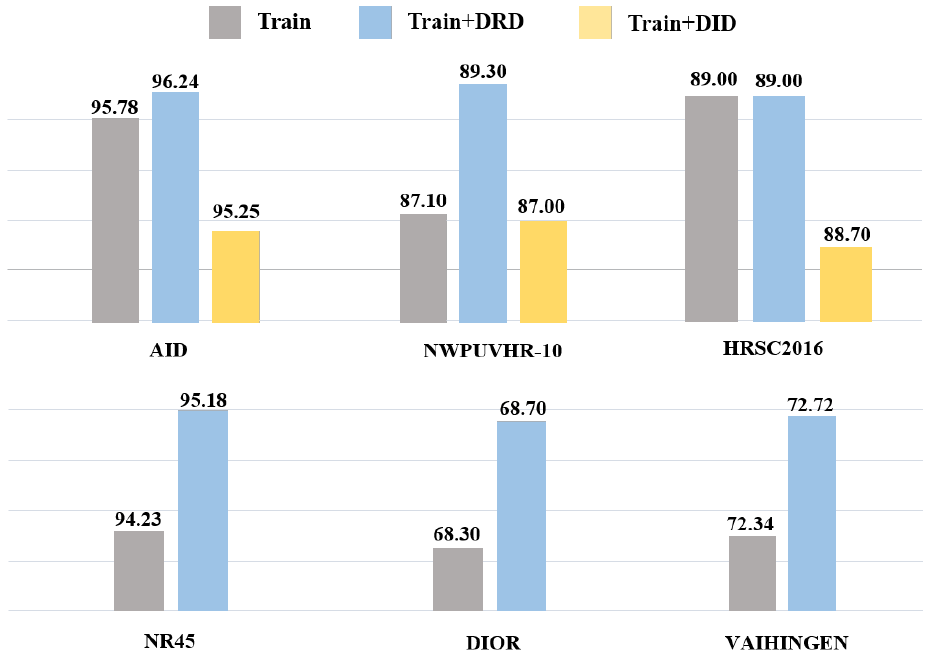
Figure 8. Discussion on different data expansion applied for the further self-supervised pre- training step. Notably, AID [19] and NR45 [20] are reported in Top-1 accuracy; NWPUVHR-10 [24], HRSC2016 [26] and DIOR [23] are reported in mAP@0.5; VAIHINGEN [21] is reported in